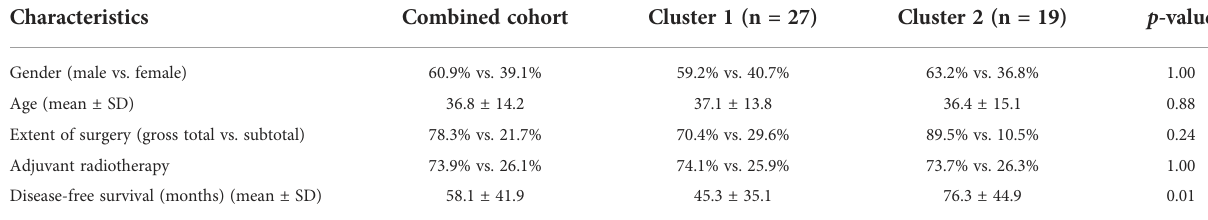
TABLE 1 Clinical characteristics of skull-base chordomas.